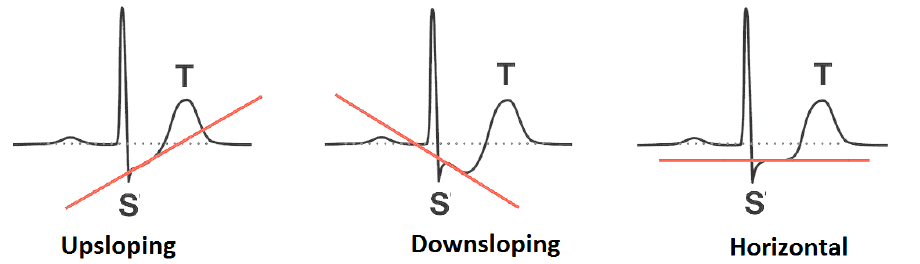
Figure 5. Pictographic view of ST-segment (source: https://litfl.com/st-segment-ecg-library (ac- cessed on 3 October